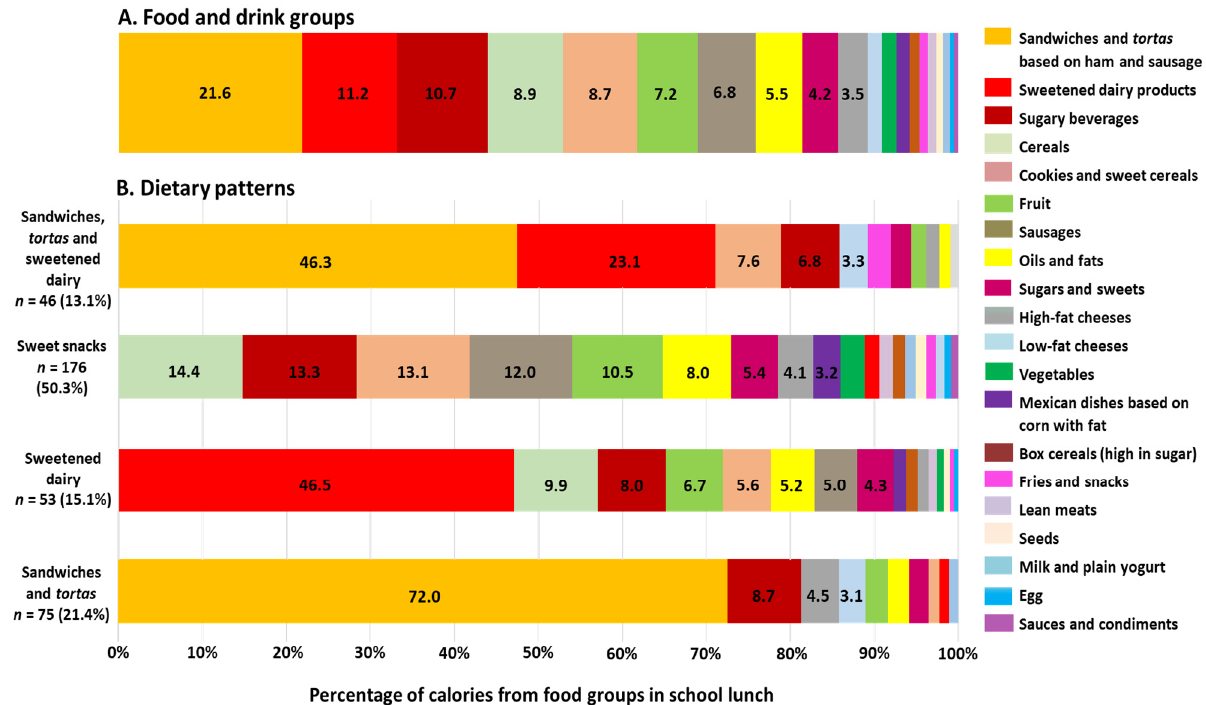
Figure 2. ( A ) Energy percentage provided by the different food groups included in the school lunch. ( B ) Dietary patterns from school lunch consumed by children ( n = 350) and energy percentage provided by the food groups. Table 2. Energy and macronutrient contribution by dietary patterns.